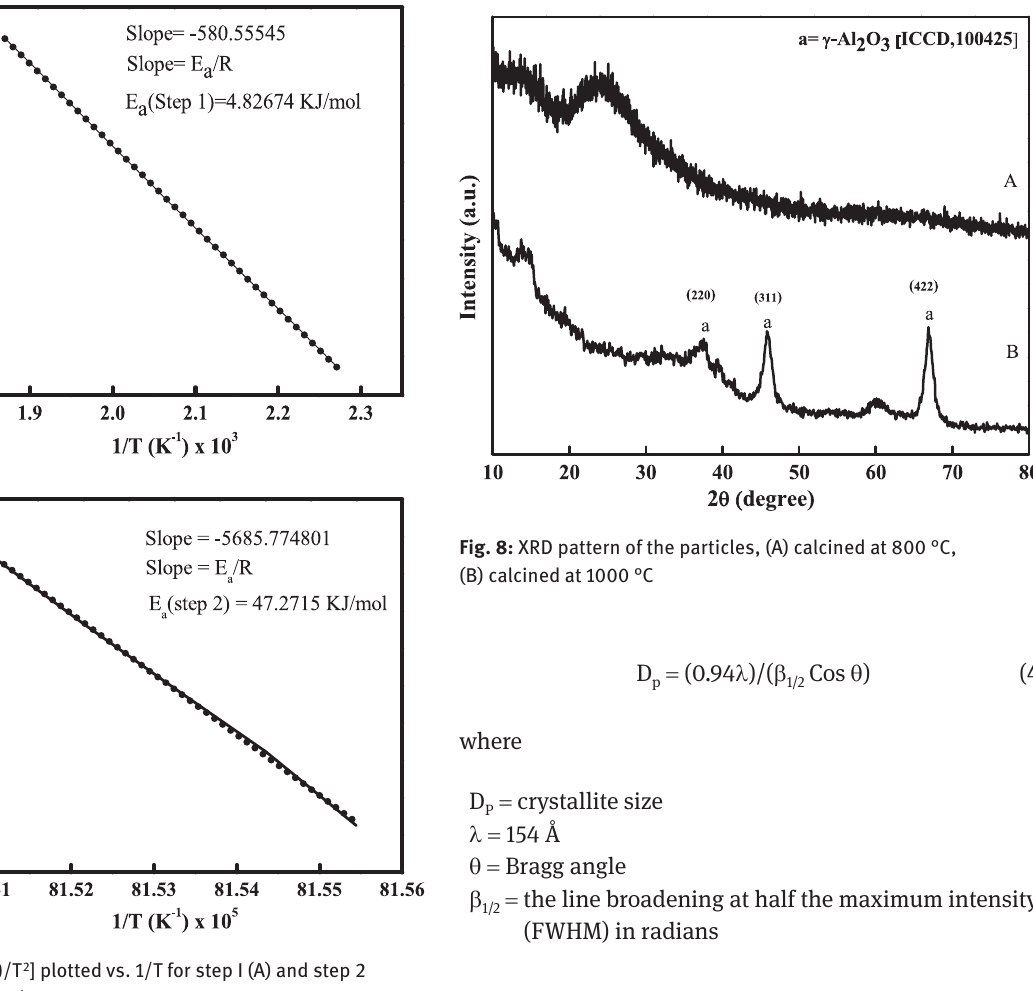
Fig. 7: ln[ − ln(1 − α )/T 2 ] plotted vs. 1/T for step I (A) and step 2 (B) as shown in Fig. 6